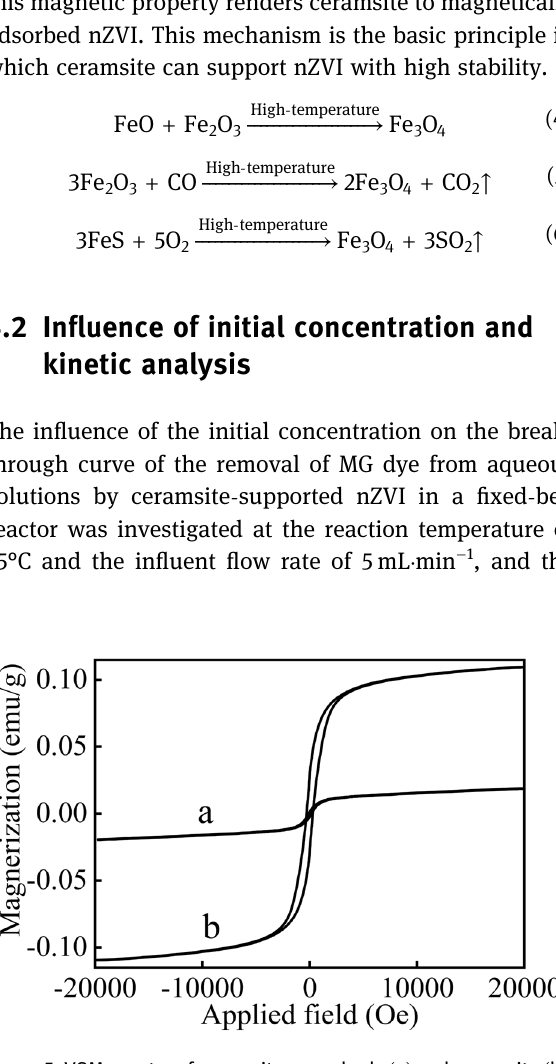
Figure 5: VSM spectra of ceramsite green body ( a ) and ceramsite ( b )